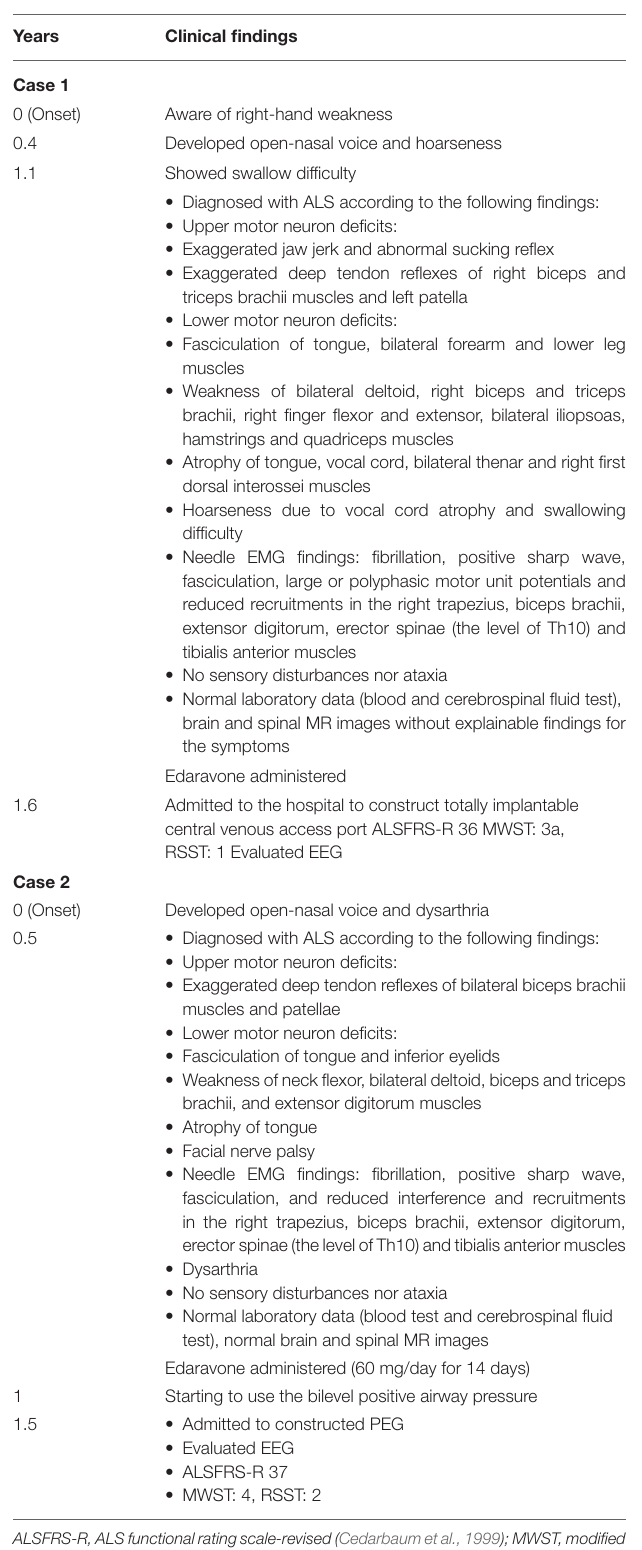
TABLE 1 | Clinical findings of Case 1 and Case